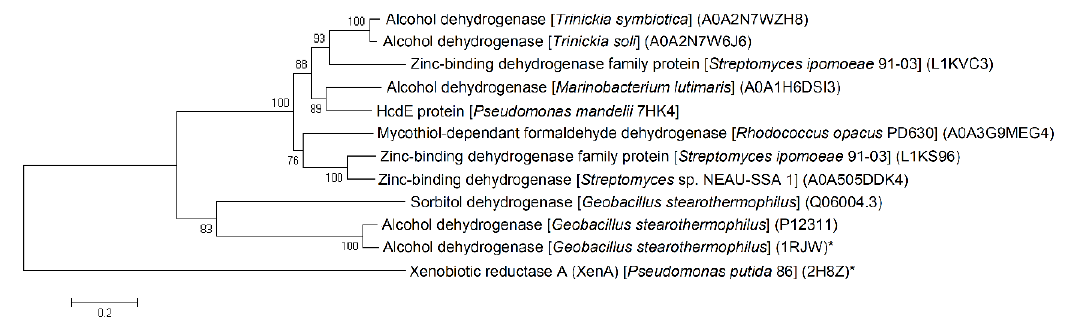
Figure 5. Phylogenetic tree of HcdE protein from Pseudomonas mandelii 7HK4 bacteria. Neighbor joining analyses were performed on the closest homologues with or without known structures and/or function. The numbers on the nodes indicate how often (no. of times, %) the species to the right grouped together in 1000 bootstrap samples. Bars represent the number of amino acid substitutions per site. UniProt/PDB accession numbers are given in parentheses. Proteins with known structure and/or function are marked with an asterix (*).